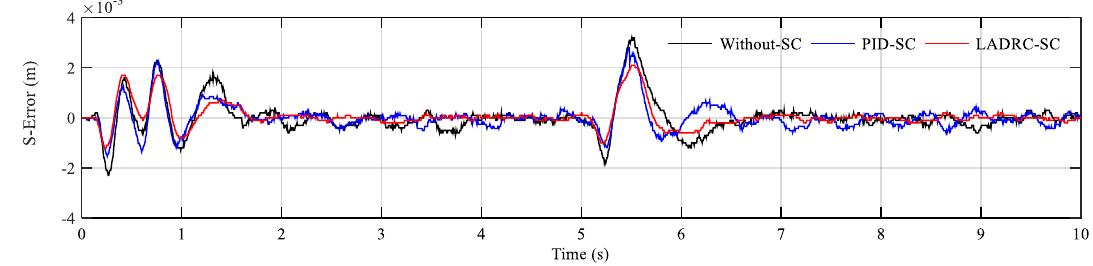
Figure 12. Synchronization error comparison results of the step signal.